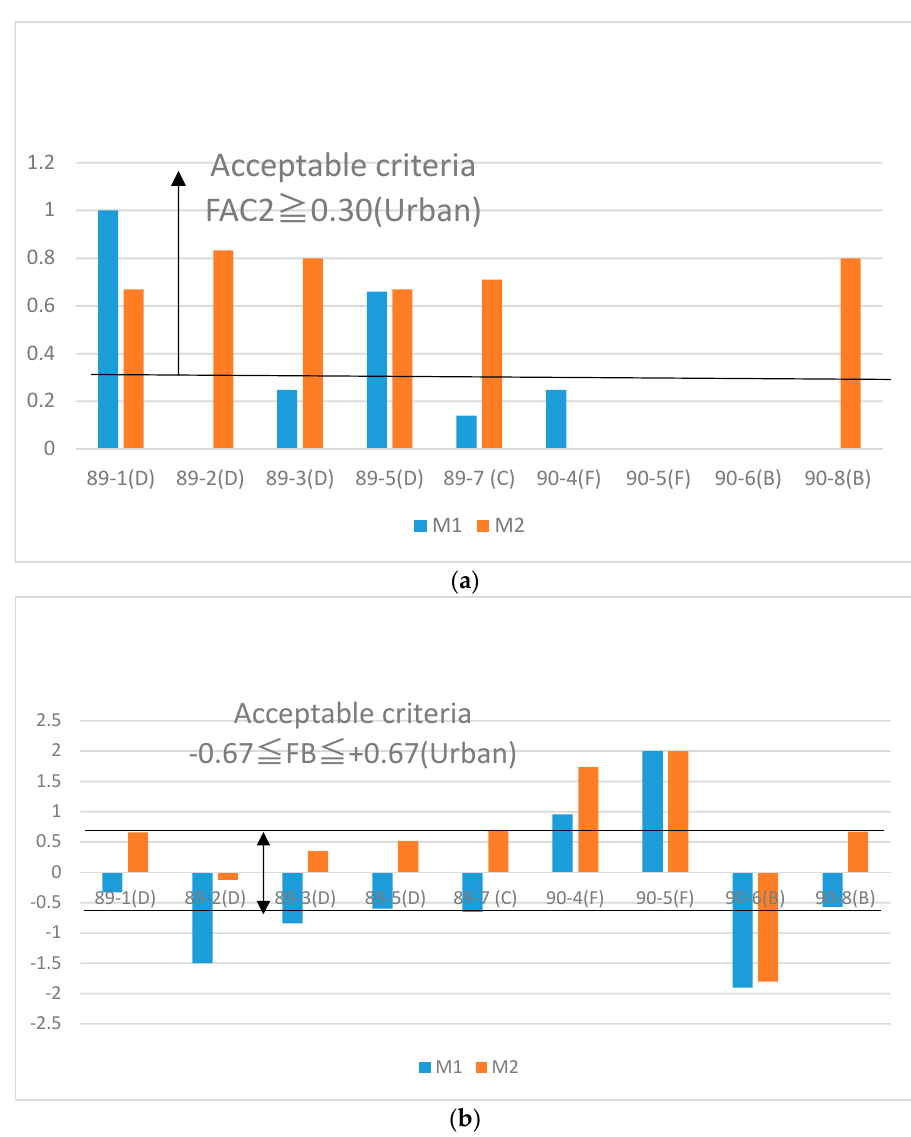
Figure 15. Comparison of calculated results with acceptability criteria, where no bar at a run number means zero. ( a ) Factor 2 (FAC2); ( b ) Fractional mean bias (FB).